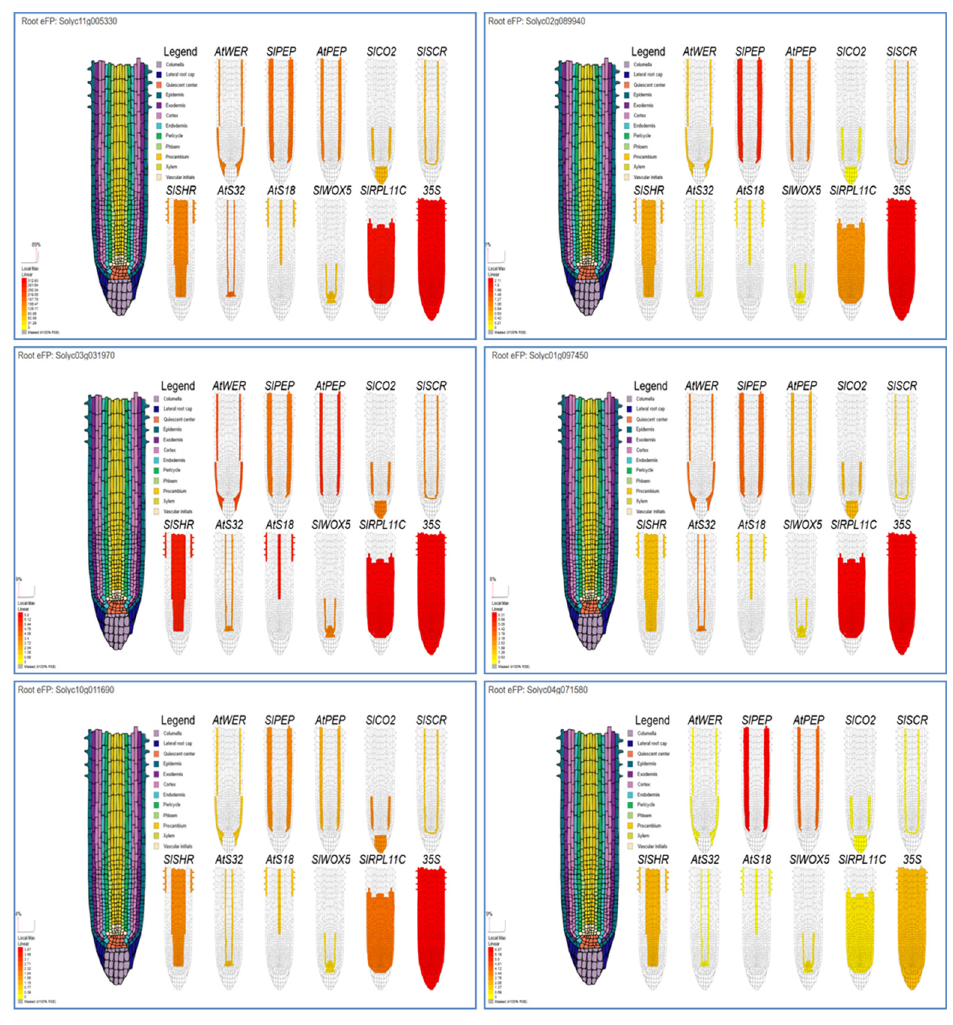
Figure 3. The putative expression of Solyc11g005330, Solyc02g089940, Solyc03g031970, Solyc01g097450, Solyc10g011690, and Solyc04g071580 genes with different root cell types and/or tis- sues that related tovarious promoters. The more intense the red color of the expression bar, the more gene expression detected [ 43 ] .